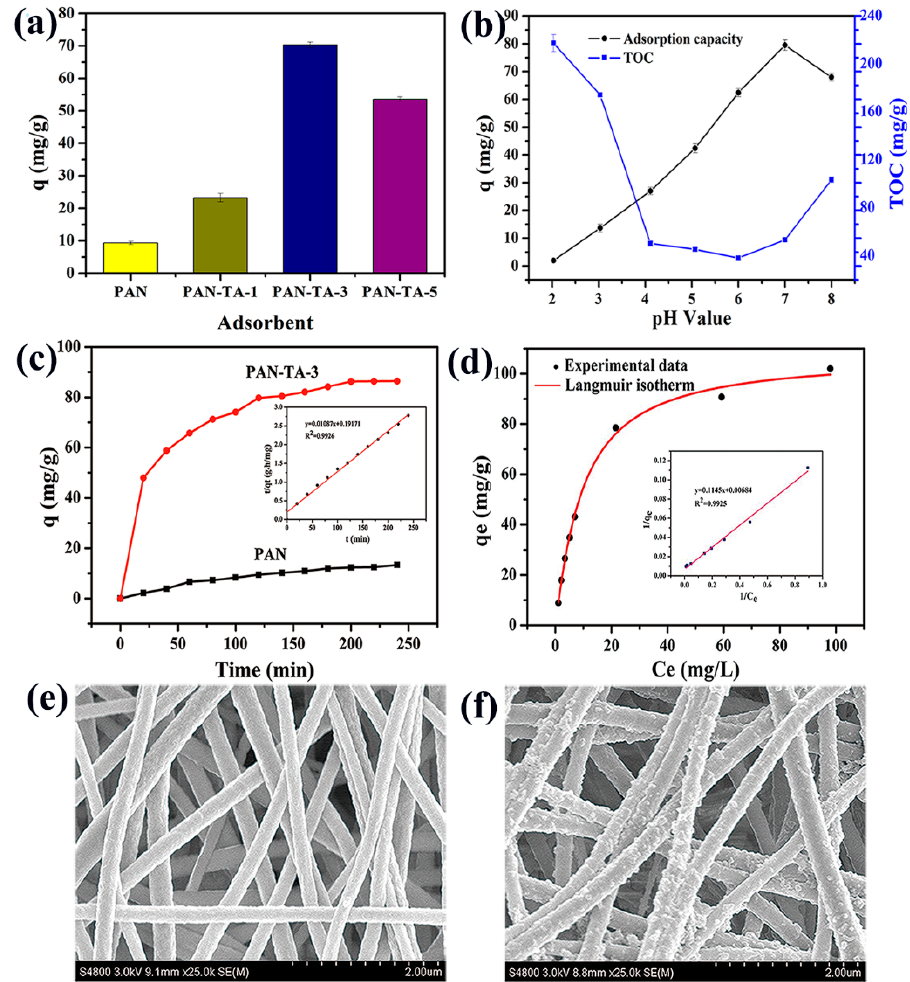
Figure 6. ( a ) Adsorption capacities of the co-blended PAN–TA NFs with different TA content; ( b ) effect of initial pH value on Cr(III) adsorption capacity and TOC value by PAN–TA-3 NFs; ( c ) adsorption kinetics on PAN–TA-3 NFs (the inset is their pseudo-second-order kinetic plots); ( d ) adsorption isotherms for Cr(III) adsorption (the inset is the corresponding Langmuir plots of Cr(III) on PAN–TA-3 NFs for over 120 min); SEM image of PAN NFs ( e ) and PAN–TA-3 NFs ( f ) after adsorption Cr(III)-collagen complexes for over 120 min.